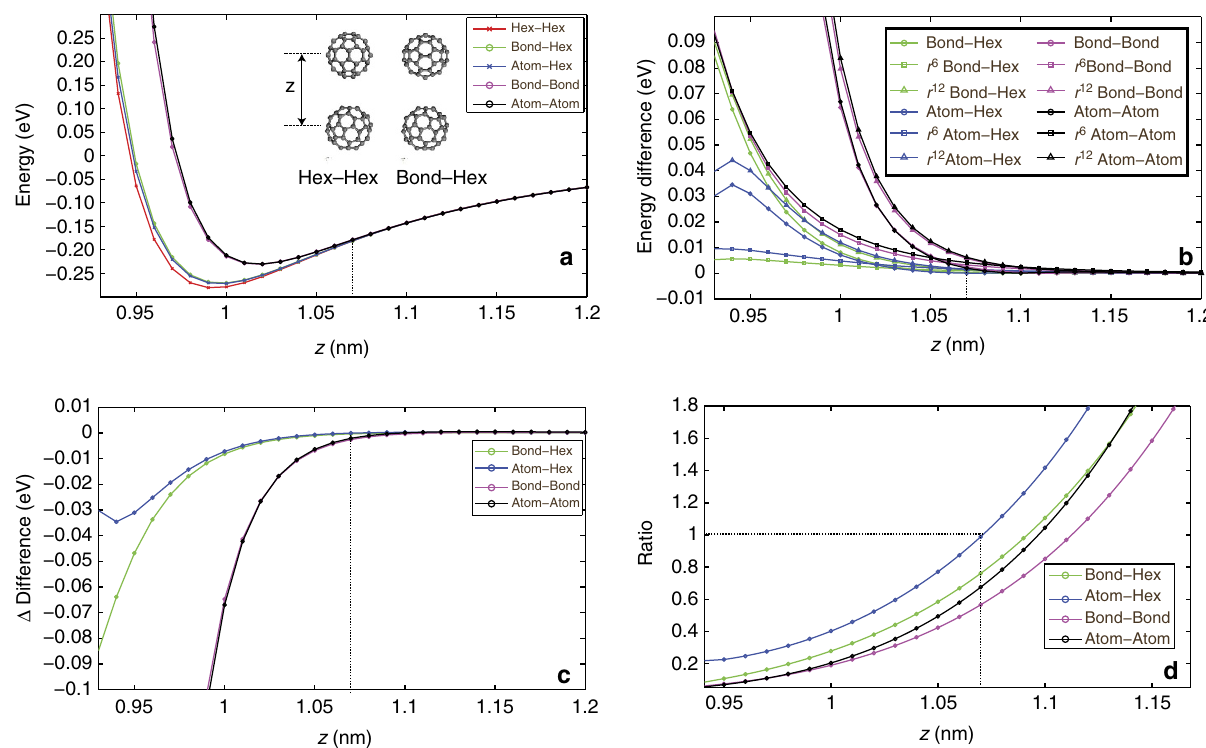
Figure 4 | Investigating the origin of the variation in potential energy minimum. ( a ) Variation in potential energy between two C 60 molecules due to variation in rotational orientation, the terms in the legend refer to the facing part of the molecule. Inset, representative ball-and-stick models showing two of the simulated orientations. ( b ) Modulus of the difference in U total , U r 6 , and U r 12 , between stated orientation and the Hex–Hex orientation. ( c ) Difference of variation in U r 6 and U r 12 terms (that is, D U r 6 j j ). Negative values indicate the U r 12 term dominates the difference in energy between the two configurations. ( d ) Ratio of variation in U r 6 and U r 12 terms. Values above 1 indicate the U r 6 term has a larger contribution. Dotted lines indicate the separation at which the U r 6 term first becomes